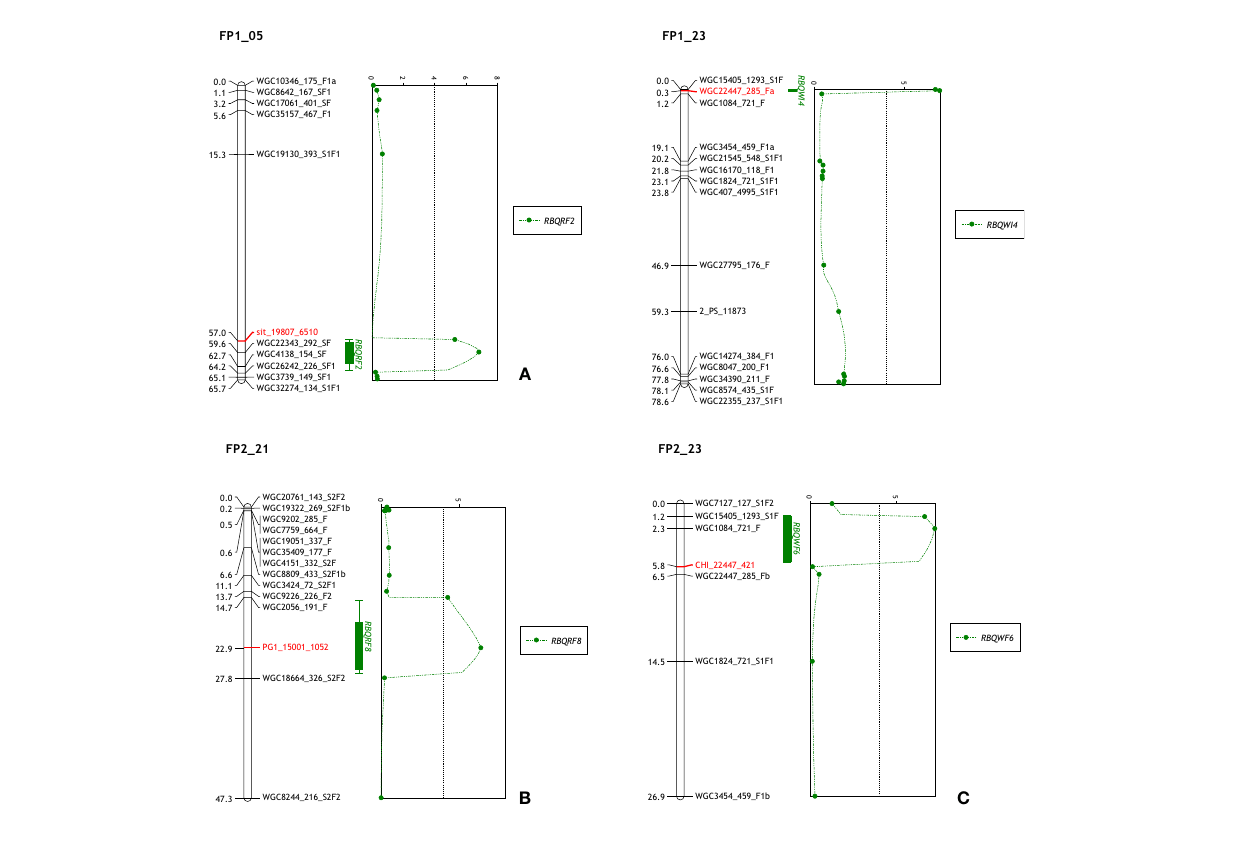
FIGURE 1 Mapped CGs and QTL positions. (A) ghsitiens mapped on FP1_05 in the region of QTL RBQRF2. (B) ghPG1 mapped on FP2_21 in the region of QTL RBQRF8. (C) The QTLs RBQWI4 and RBQWI6 in the maternal and paternal LG23 of F population. The marker WGC22447_285_Fa is a KASP marker from contig22447 and CHI_22447_421 is a marker from the same transcriptome contig used in HRM for validation of contig.